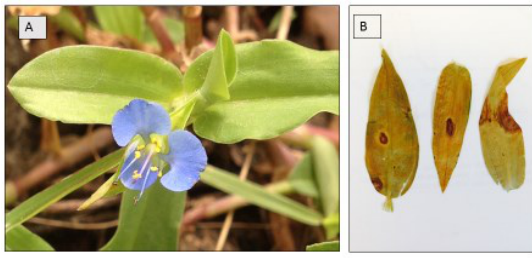
Figure 1. Commelina diffusa photographs. ( A ): flowering plant in the field; ( B ): pressed/dried specimen exhibiting leaf spotting incited by P. commelinicola